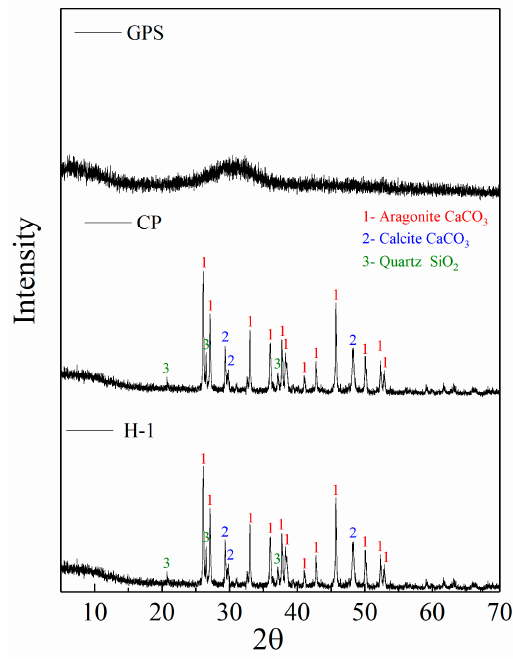
Figure 2. XRD patterns of the GPS, CP and sample